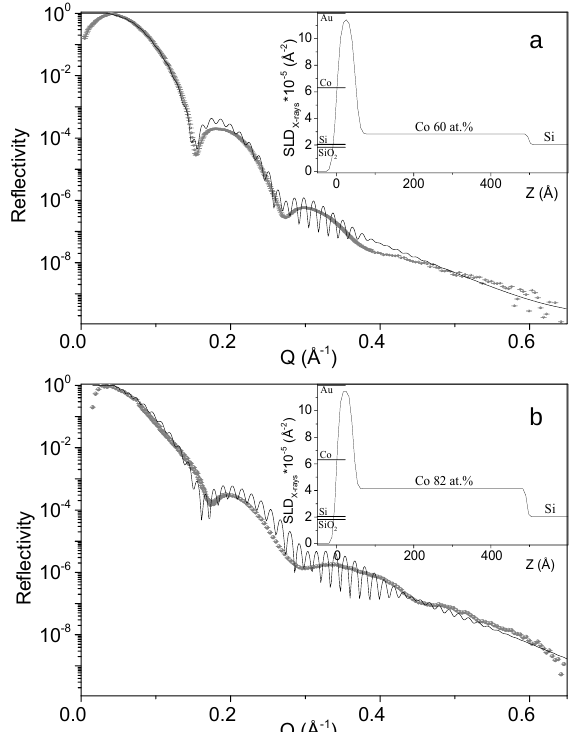
Figure 4. Synchrotron X-ray reflectometry from Au/SiO 2 (60 at.% Co)/Si ( a ) and Au/SiO 2 (82 at.% Co)/Si ( b ) heterostructures. The gray points are experimental data, the solid line is the theoretical curve corresponding to the model of the electron-density distribution shown in the inset with the indication of electron densities plotted for the pure components of the